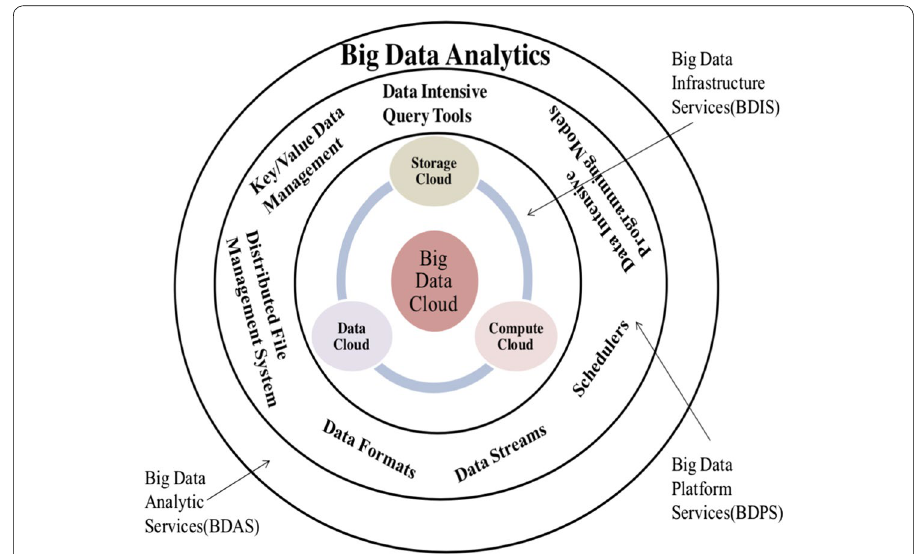
Fig. 1 Big data cloud